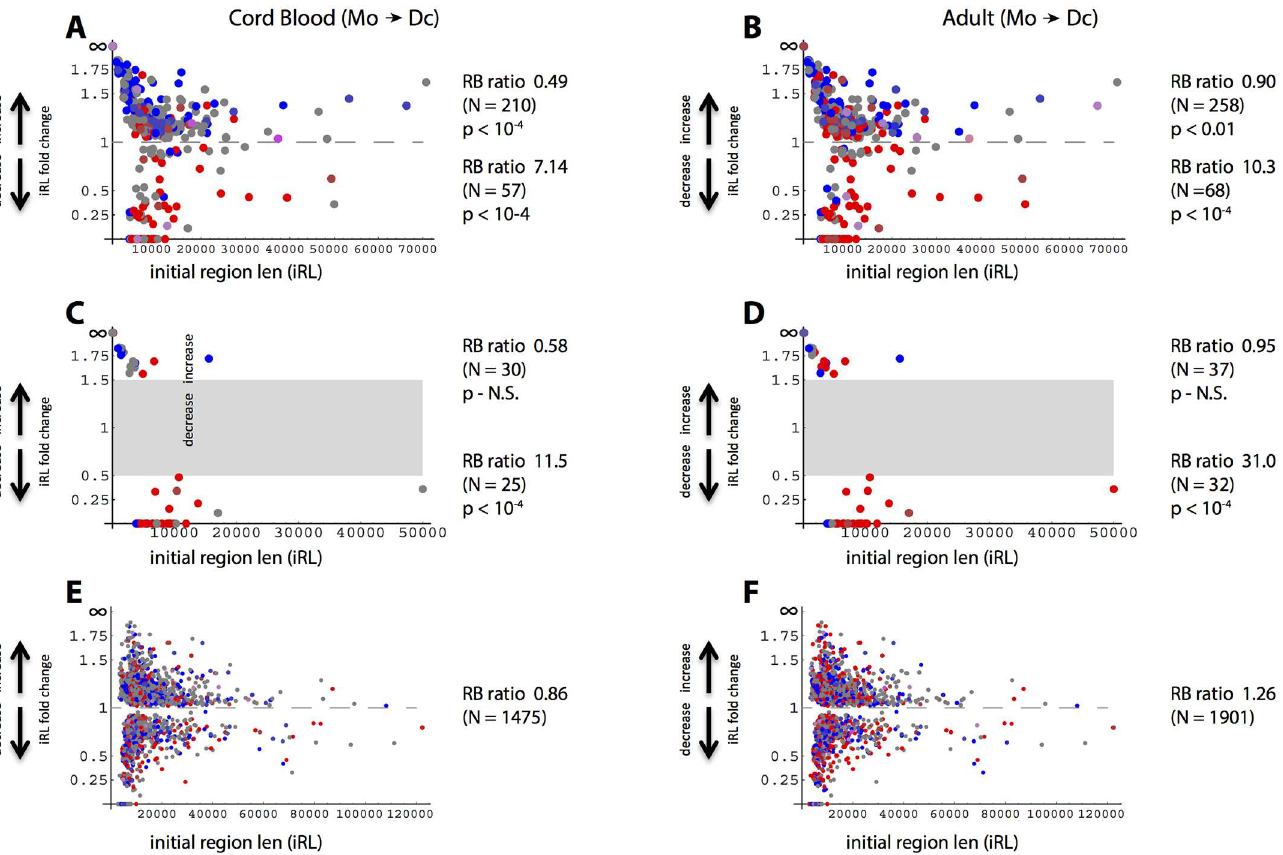
Fig 4. Region span vs. significant differentiation-dependent gene expression change. PcG regions, plotted by initial span (x-axis) and monocyte to DC differentiation-linked fold change (y-axis), were assigned colors according to the ratio of overlapped genes that exhibit significant (FDR < 0.05) change in expression. Points representing regions with significantly increased RNA levels are red, decreased levels are blue, whereas regions overlapping equal numbers of up- and down-regulated genes are gray. Intermediate hues reflect either: i) proportionality, if the most but not all of the genes associated with a given region exhibited consistent significant expression change, or ii) multiple regions associated with different predominant gene expression patterns and represented by points that overlap. Panels A and B show only regions where the differentiation-linked fold change in span was consistent, i.e, > 1 in all nine monocyte-DC comparisons or < 1 in all comparisons. Panels C and D show only regions where the differentiation-linked fold change in span was consistent and either exceeded or fell below threshold values. Gray rectangles in panels CD denote areas where the threshold filter excluded regions from being plotted. Random sampling with replacement was used to derive p-values for RB (red-blue) ratios, where regions overlapping all or a majority of significantly up- or down-regulated genes were pooled.